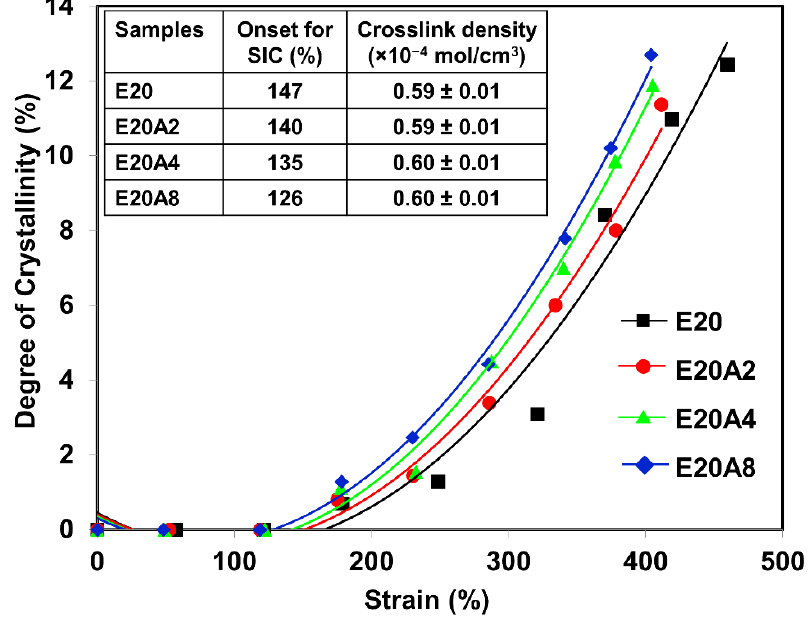
Figure 12. Strain dependence of the degree of crystallinity in ENR/HNT composites filled with untreated and acid-treated